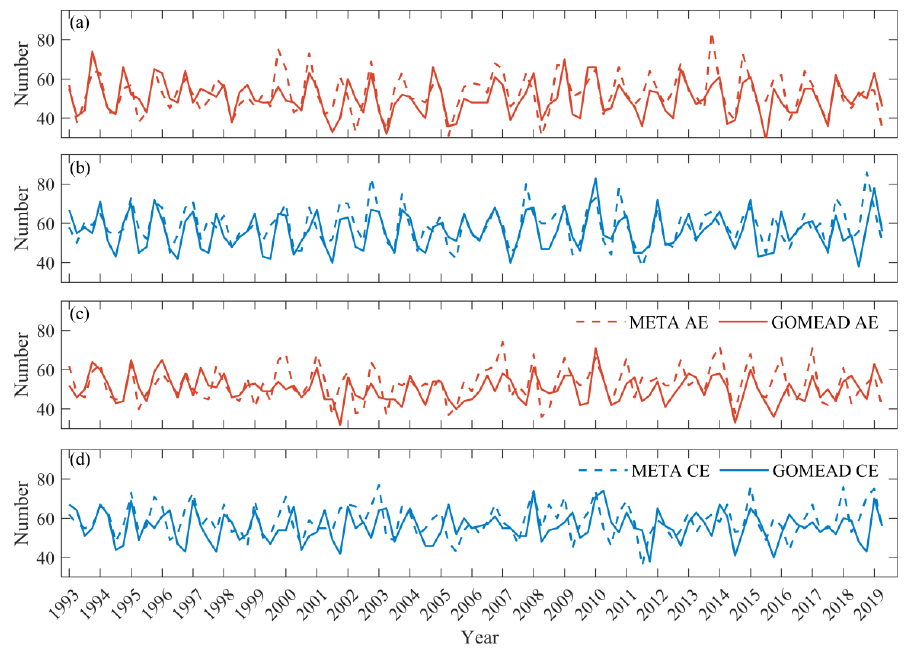
Figure 6. Interannual variation of the number of generated ( a ) AEs and ( b ) CEs and terminated ( c ) AEs and ( d ) CEs in the SF region. The time resolution is three months. The monthly variation of the number of eddy generation in the SF region showed a more consistent trend than the annual variation (Figure 7a,b), with the eddy generation peak around March and the minimum around September. Due to differences in eddy lifespan between the two datasets, the monthly variation trend of eddy terminated in the two datasets is somewhat different, with the peak of eddies in the META dataset from March to May, and the peak of eddies in the GOMEAD dataset from May to July (Figure 7c,d).